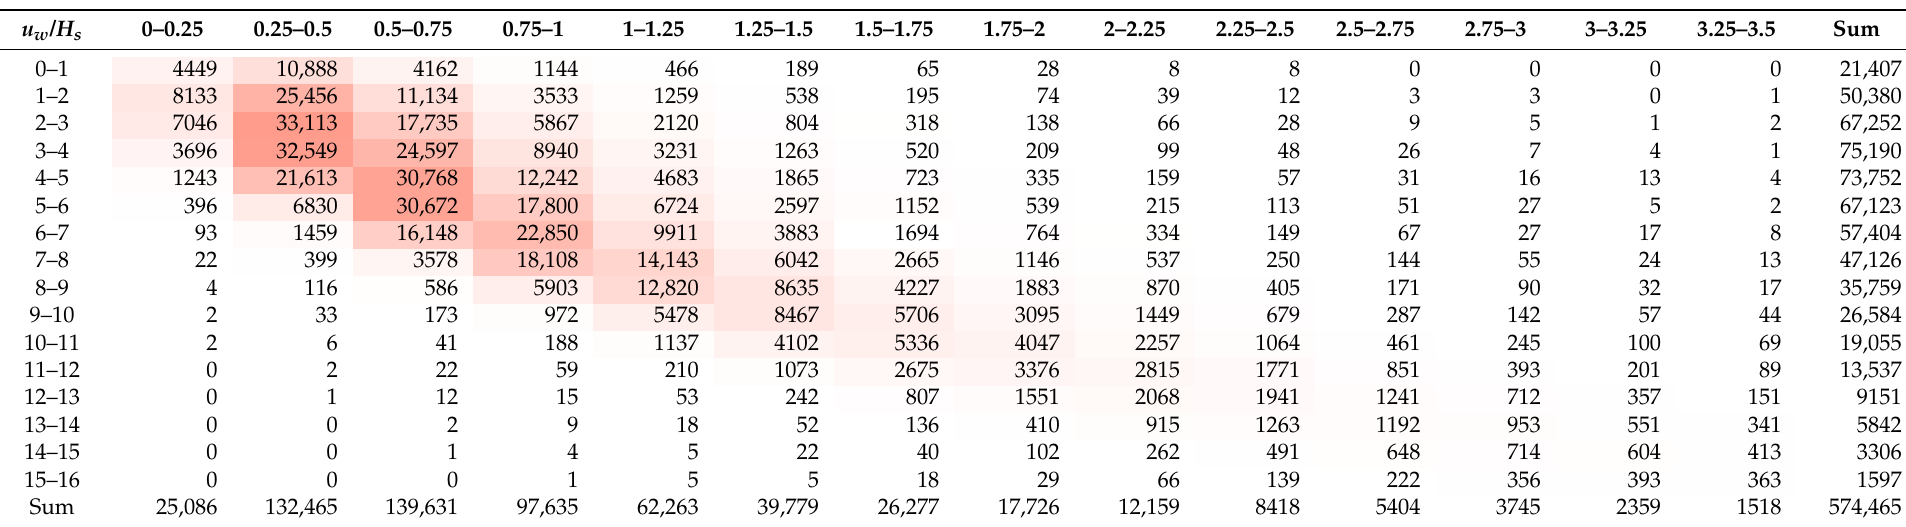
Table A9. Wind speed with significant wave height for South Adriatic region (locations